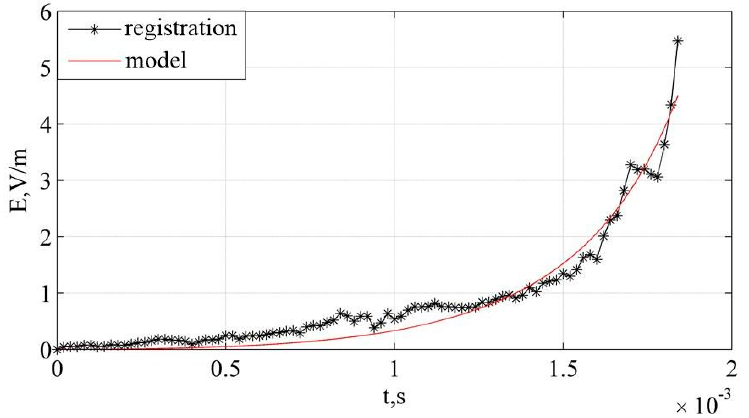
Figure 13. Description is the same as in Figure 10, except the distant positive lightning leader E-field change, which is related to Case #3 from Table 1 (see Figure 7).